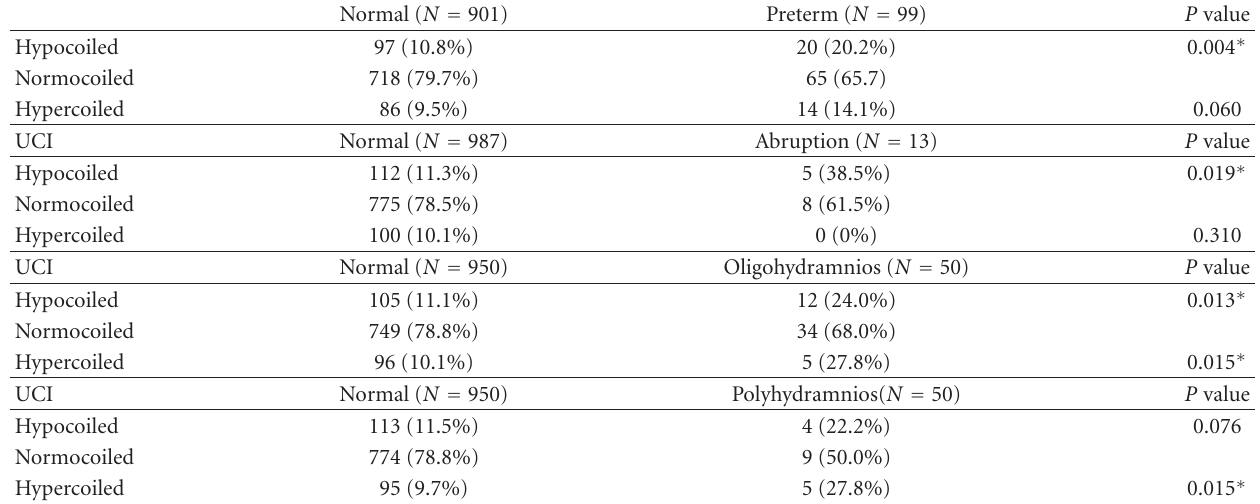
Table 3: Distribution frequencies of the three groups according to the maternal factors.